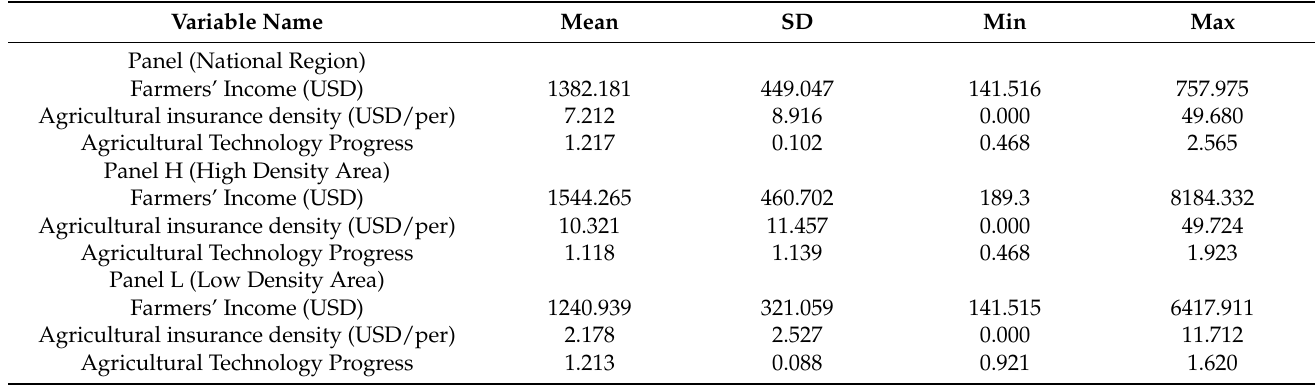
Table 1. Statistical